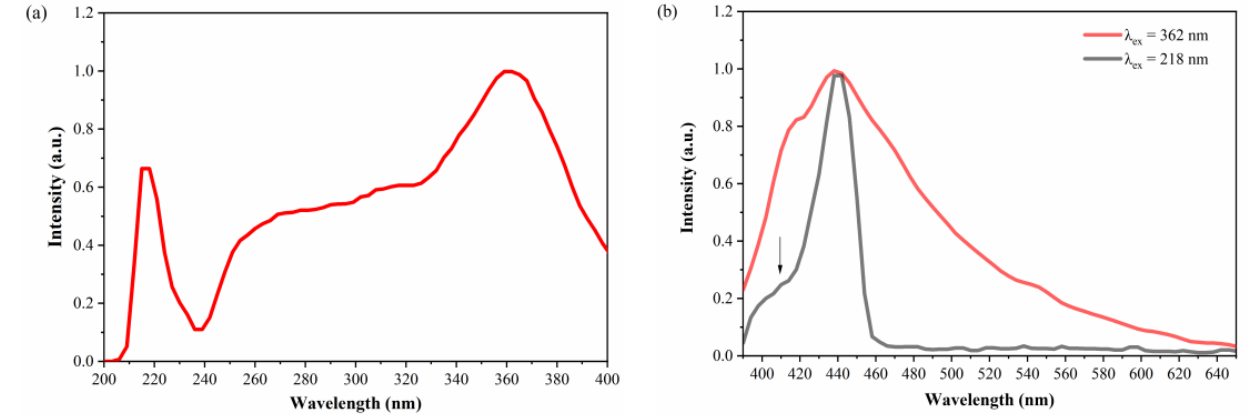
Figure 8. ( a ) Fluorescence excitation spectra and ( b ) emission spectra with different pump sources (red, 362 nm pump; and black, 218 nm pump) of the TiO 2 crystal. (red, 362 nm pump; and black, 218 nm pump) of the TiO 2